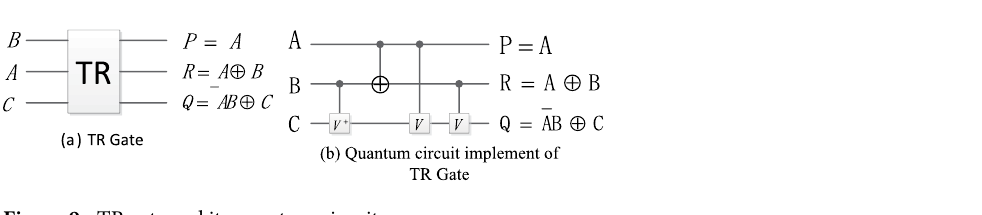
Figure 9. TR gate and its quantum